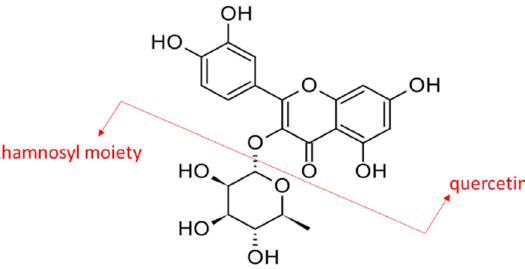
Figure 1. Chemical structure of quercetrin or quercetin O-glycoside composed of quercetin linked with a rhamnosyl moiety via a C3 glycosidic linkage.